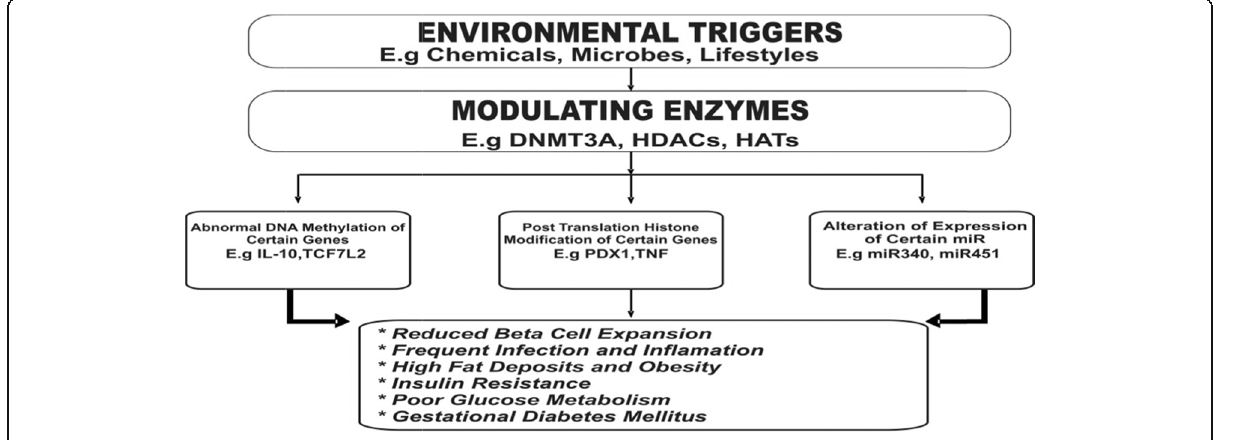
Fig. 3 Epigenetic etiology of gestational diabetes